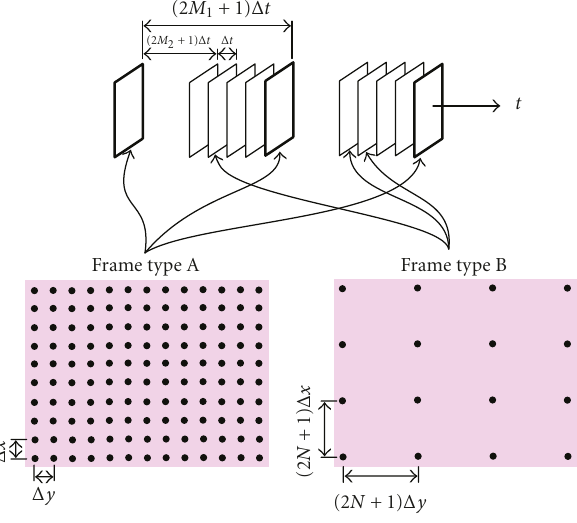
Figure 6: Nonuniformly sampled video